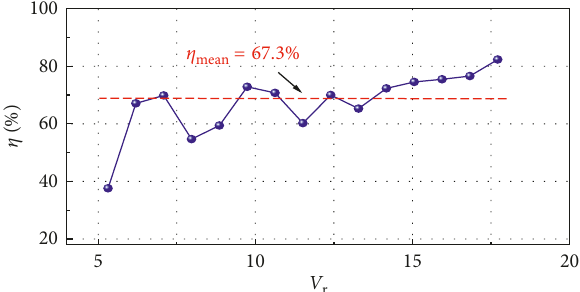
Figure 12: VIV suppression efficiencies of the main inclined flexible cylinder with control rods versus the reduced velocity.